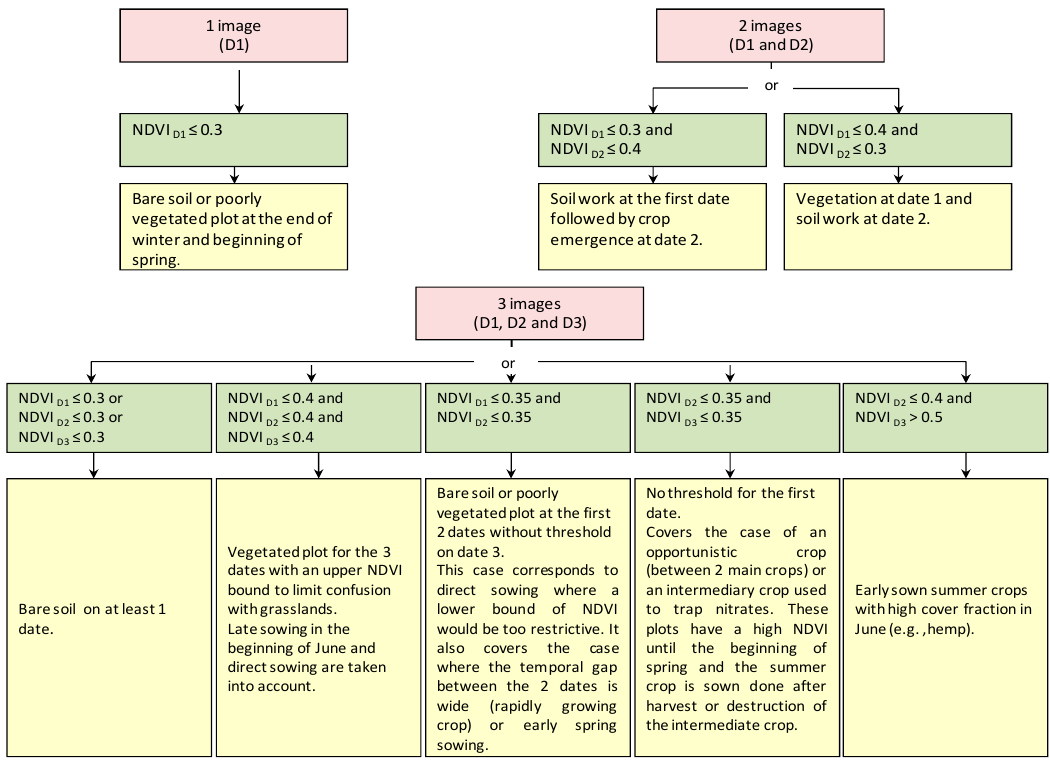
Figure 7. Summary of the rules applied for the summer crop detection (in pink: number of images; in green: conditions; in yellow: surface states and/or agricultural practices).